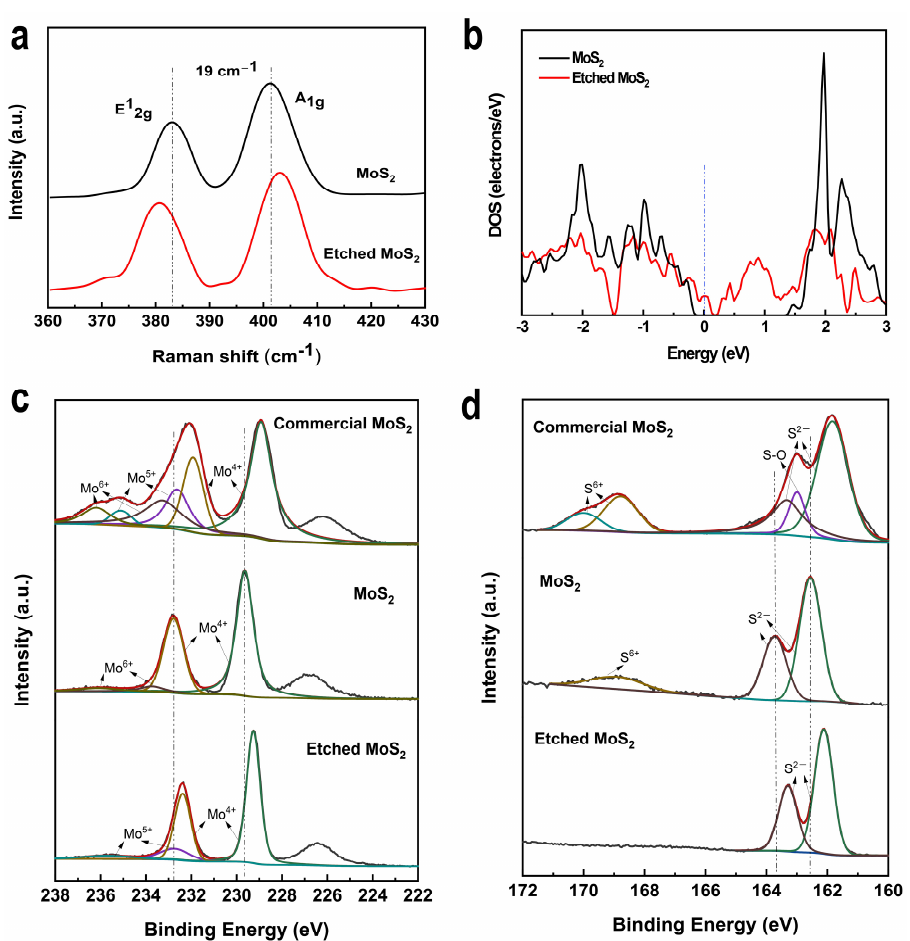
Figure 2. ( a ) Raman spectra and density of states of CVD grown MoS 2 and etched monolayer MoS 2 . ( b ) Calculated band structures of etched MoS 2 using the Fermi level as a reference. XPS data of commercial MoS 2 powder, CVD grown monolayer MoS 2 , and etched monolayer MoS 2 at the binding energies of ( c ) Mo 3d and ( d ) S 2p.